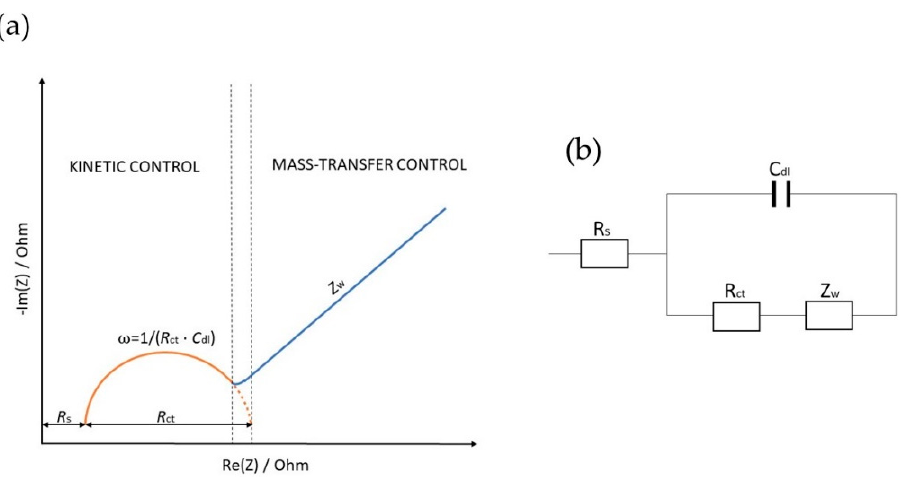
Figure 1. Representation of the Nyquist diagram ( a ) with the interrelated equivalent electric circuit EEC ( b ).